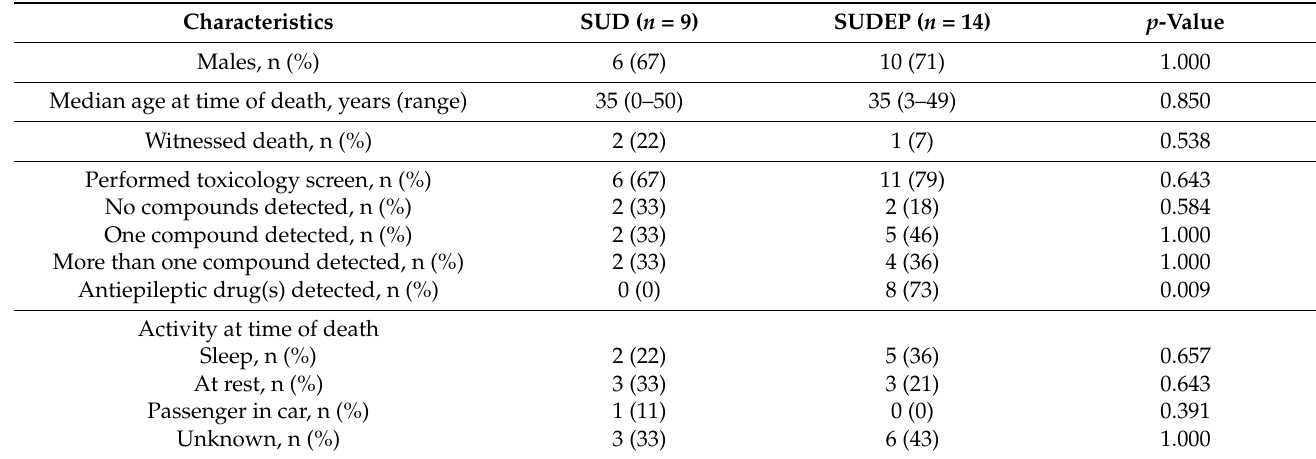
Table 1. Descriptive data of the study population.